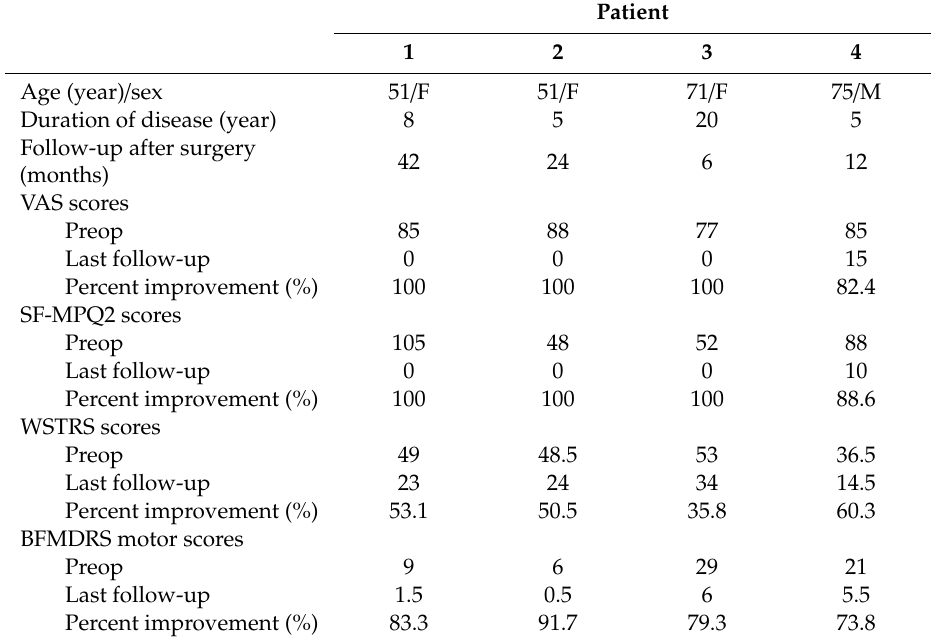
Table 1. Clinical summary of patients with painful cervical dystonia who underwent burst spinal cord